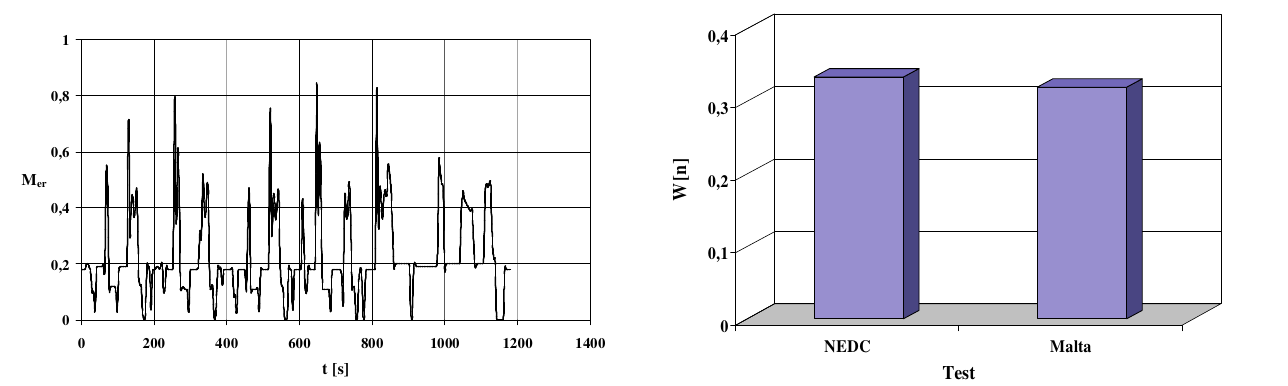
Fig. 2. Engine speed characteristic for the Malta test